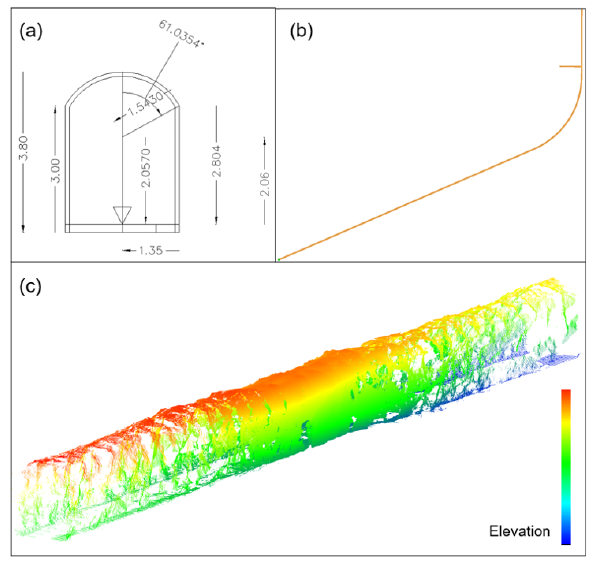
Figure 1. The design model and terrestrial laser scanning point clouds of a tunnel. (a) Design cross-section; (b) design 3D solid model; (c) terrestrial laser scanning point clouds after